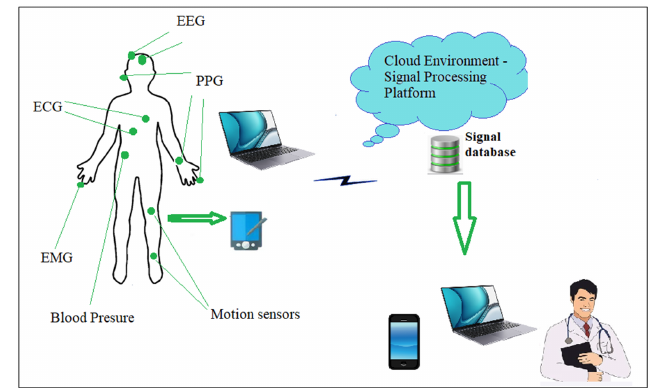
Figure 1. Scheme of a health system based on body sensors.